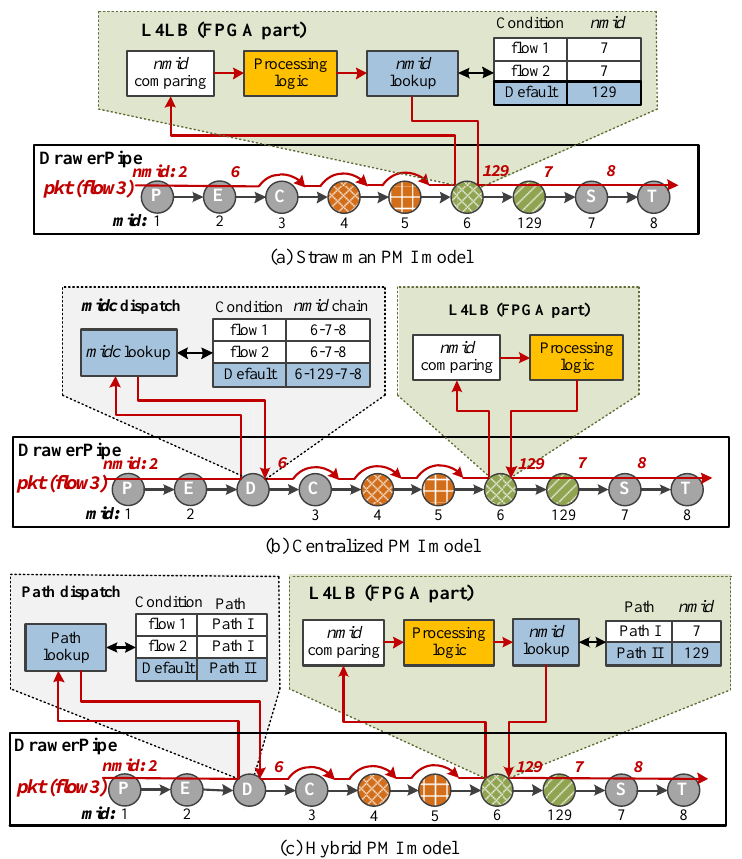
Figure 8. The mechanism of three PMI